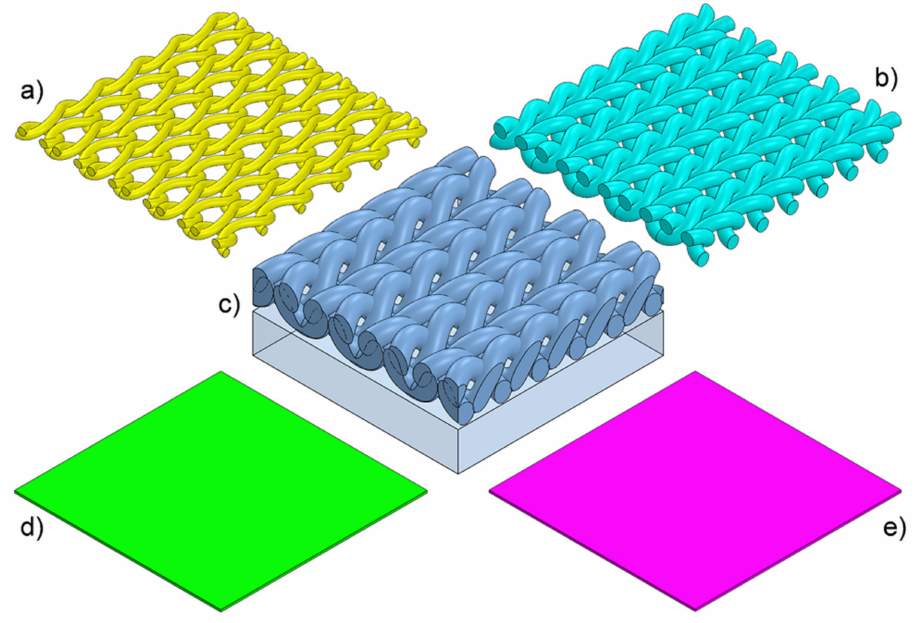
Figure 7. Images of 3D models of ( a ) knitted fabric made of Cotton LM, ( b ) knitted fabric made of Cotton HM, ( c ) brushed knitted fabric made of PES, ( d ) vapor permeable membrane made of PU, and ( e ) vapor permeable membrane made of